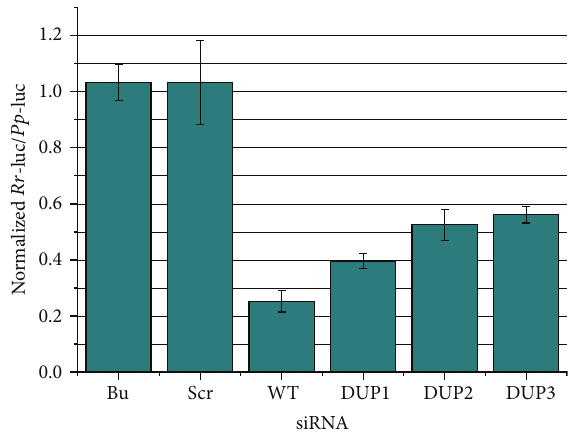
Figure 3: RNA interference activity of TTF2-modified siRNAs: DUP 1 (siRNA carrying a TTF2 unit at the 3 󸀠 -end of passenger strand), DUP2 (siRNA carrying a TTF2 unit at the 3 󸀠 -end of the guide strand) and DUP3 (siRNA carrying a TTF2 unit at both guide and passenger strands), WT (unmodified siRNA, wild type), Scr (scrambled siRNA), Bu: buffer alone. Renilla reniformis luciferase activity ( Rr -luc) (target) versus Photinus pyralis pGL3 luciferase activity ( Pp -luc) (control) after 20hrs incubation of siRNA (0.3nM) designed against Renilla gene in transiently transfected Hela cells. Ratios of target to control were normalized to a buffer control